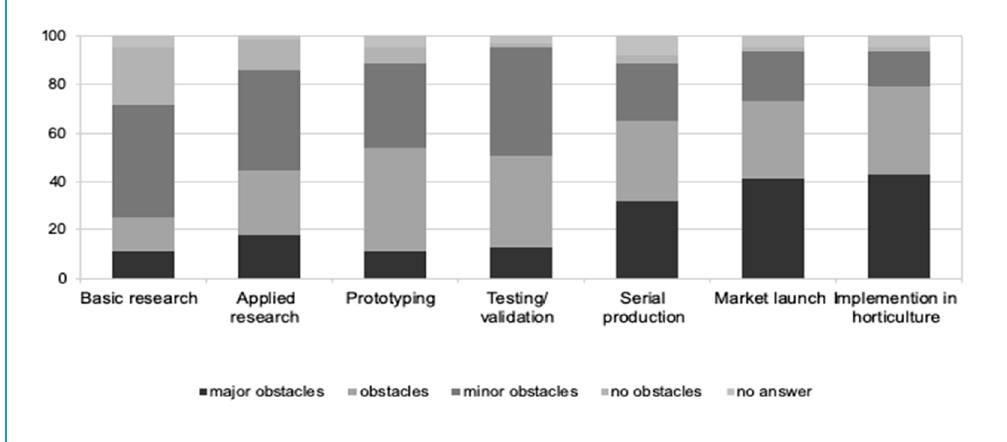
Figure 2. Barriers throughout the IP (Delphi 2. n = 24, frequency in %) own Figure based on [33].